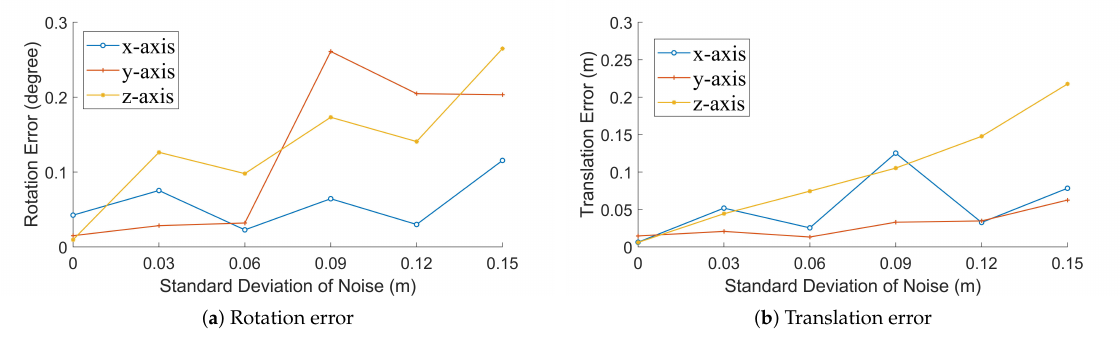
Figure 10. Errors for simulated data with different noise